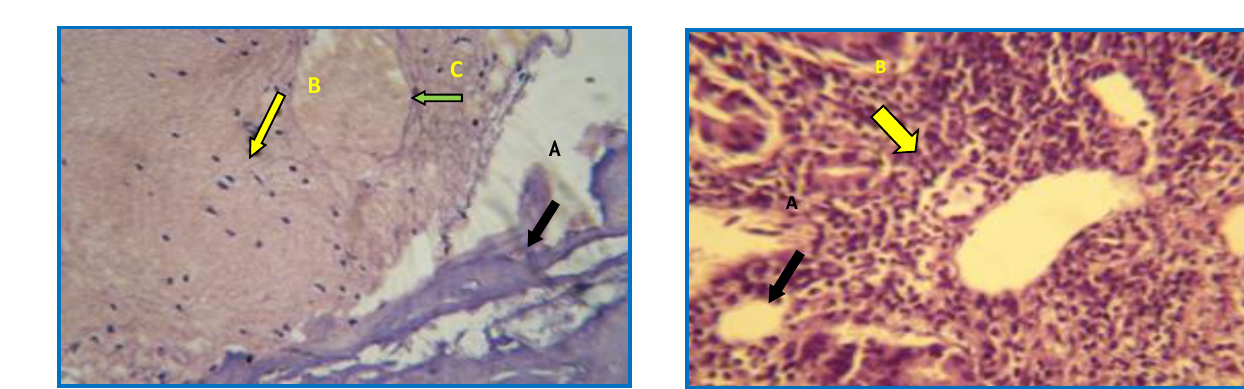
Figure, 7: Shows necrotic area (A) with fibrin deposition (B) and dilated blood vessel contain proteineus material (C). Group A, seven days post operation (H and E 40